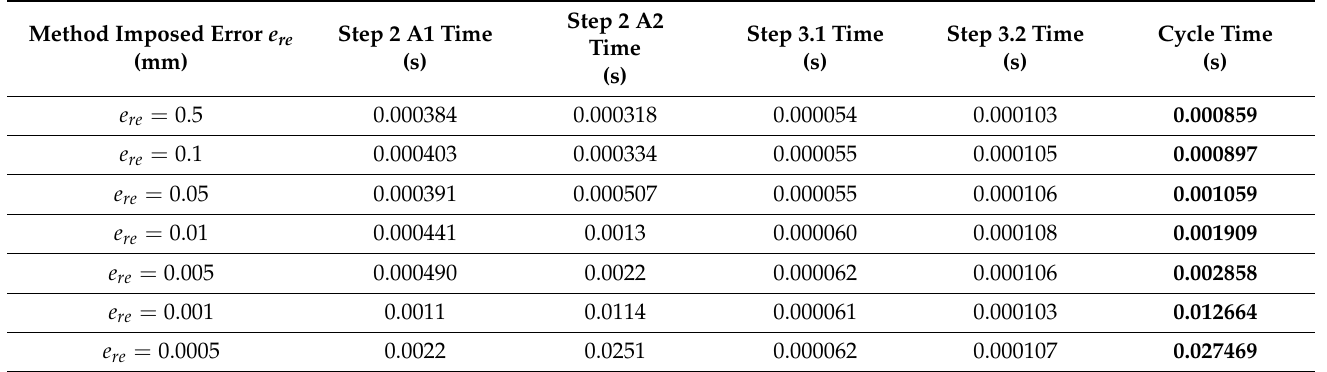
Table 3. Cycle time for different imposed values for e re .